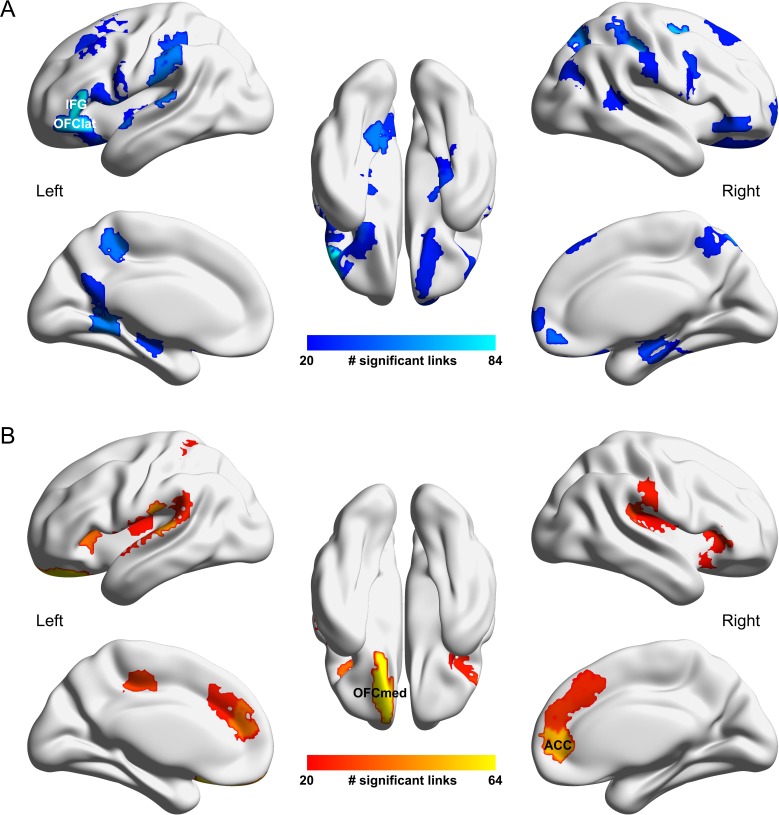
Whole brain functional connectivity difference pattern using the fconn atlas (Shen et al., 2013) for comparison with the AAL2 atlas results shown in Figure 2.We modified the fconn atlas so that it includes the AAL2 parcellation produced by Rolls et al. (2015) of the medial orbitofrontal cortex areas (OFC_med, OFC_ant, OFC_post, Rectus, and OLF) and lateral orbitofrontal cortex areas (OFC_lat, and IFG_orb). (A) The fconn areas with different functional connectivity (measured by the number of significant links p<0.001 and using a threshold of 20 links) involving that area, for the smoking group compared to the non-smoking group. (B) The same for the high drinking group compared to the low drinking group using a threshold of 10 links (p<0.001) within an area.